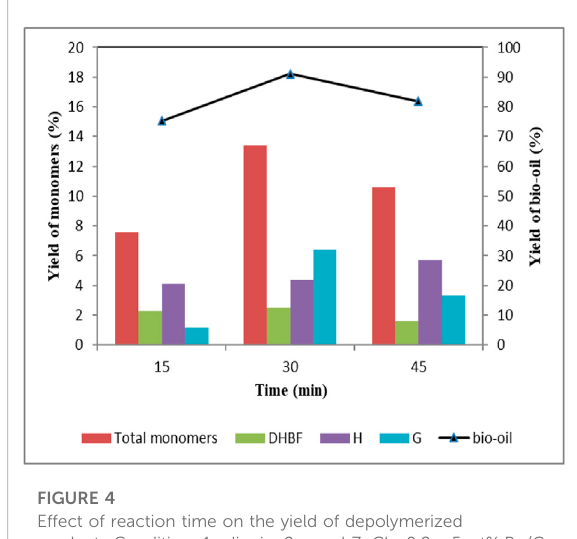
FIGURE 3 Effect of reaction temperature on the yield of depolymerized products Condition: 1 g lignin, 2 mmol ZnCl 2 , 0.2 g 5 wt% Ru/C, 20 ml methanol, 4 g formic acid, 30 min.